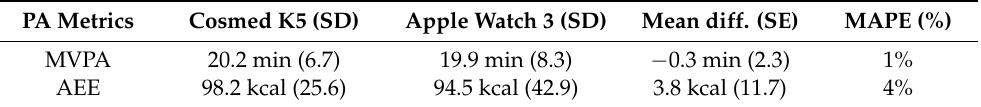
Table 2. Estimated mean (SD), mean difference (SE), mean absolute percent error between indirect calorimetry and the Apple Watch 3 under the simulated free-living condition.